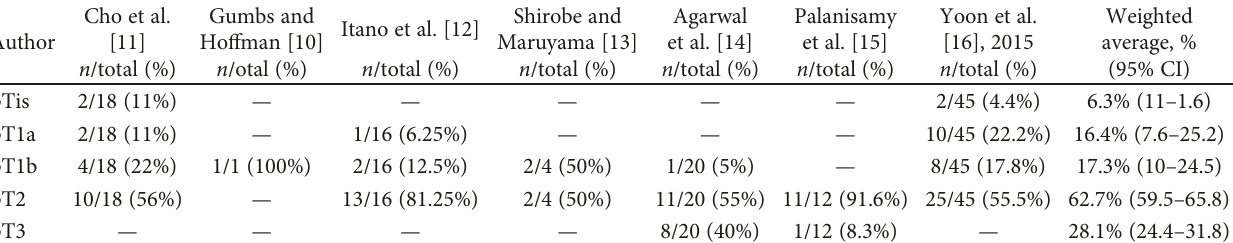
Table 2: Primary GBC staging.